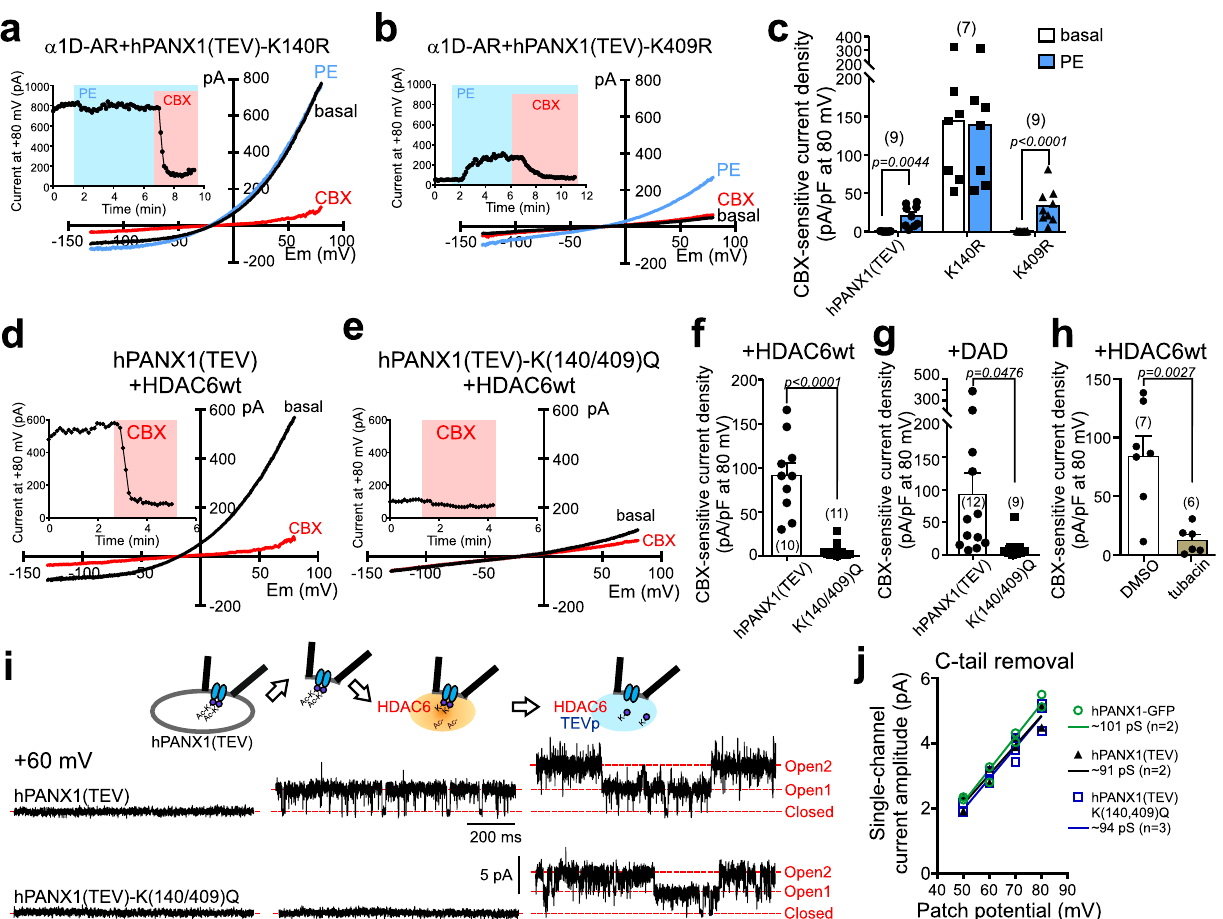
Fig. 7 HDAC6-mediated channel activation by deacetylation of Lys-140 on PANX1. a, b Basal and PE-stimulated whole-cell currents in α 1D-AR- transfected HEK293T cells expressing the indicated Arg-substituted PANX1 constructs. c Summary data (mean± s.e.m) reveal that Arg substitution at Lys- 140, but not at Lys-409, increased basal PANX1 current and occluded PE effects. n = 9, 7, or 9 cells examined over 3 independent experiments. Two-way ANOVA (F 2,22 = 9.924, p = 0.0008) with Bonferroni ’ s multiple comparisons test ( p values from comparisons are shown). d, e Effect of HDAC6 on